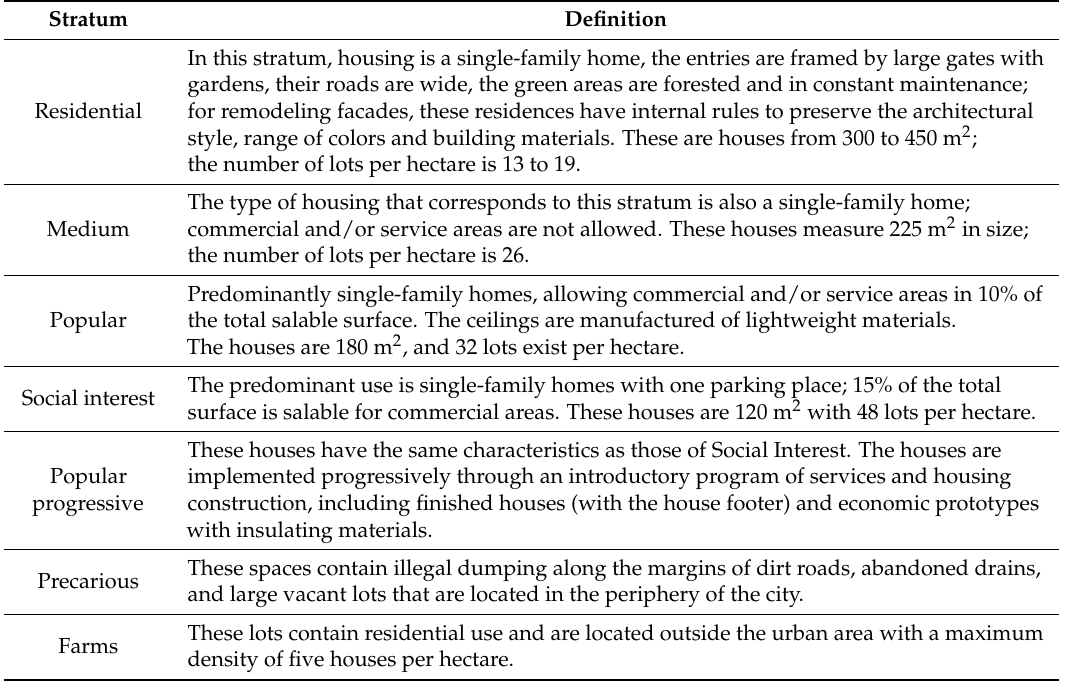
Table 1. The characteristics that identify each socioeconomic